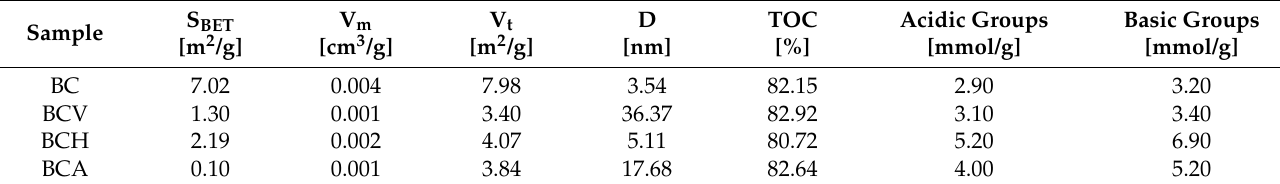
Table 3. Surface chemistry and porosity of biochars (S BET —the specific surface area; V m —the micropore volume; V t —the total pore volume, D—the average pore diameter; TOC—the total organic